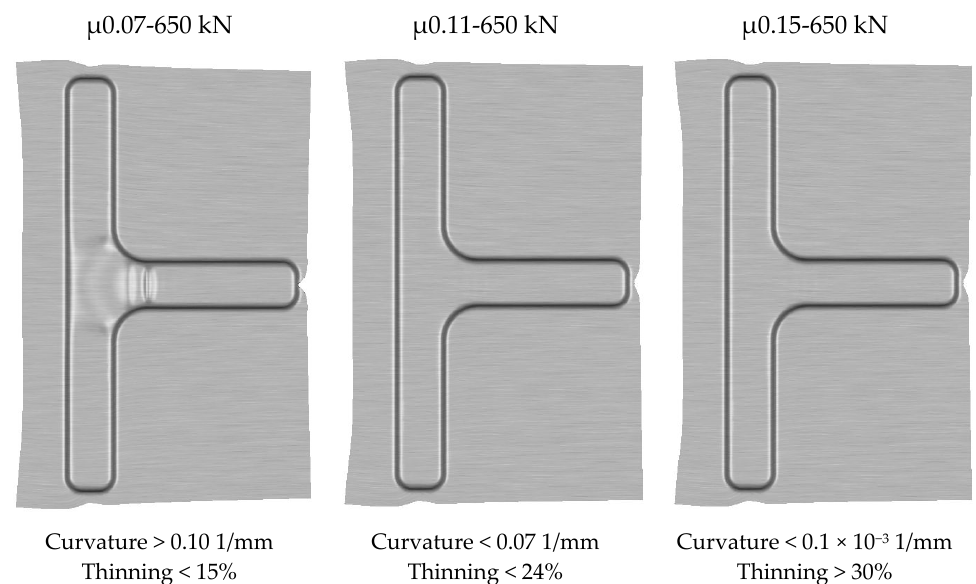
Figure 19. Formed parts’ curvature and thinning values simulated with a BHF equal to 650 kN and different friction coefficients.